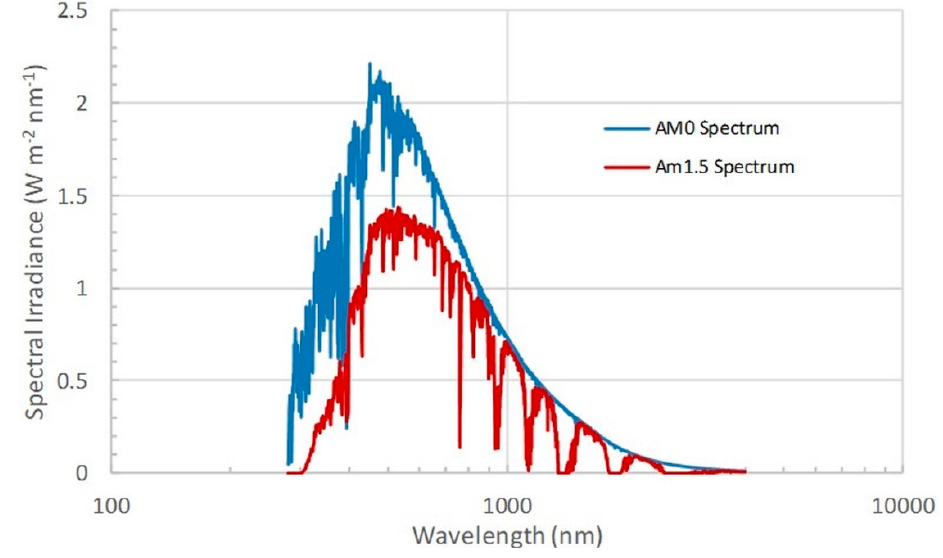
Figure 1. Spectral distribution of sun energy at AM0 and AM1.5.